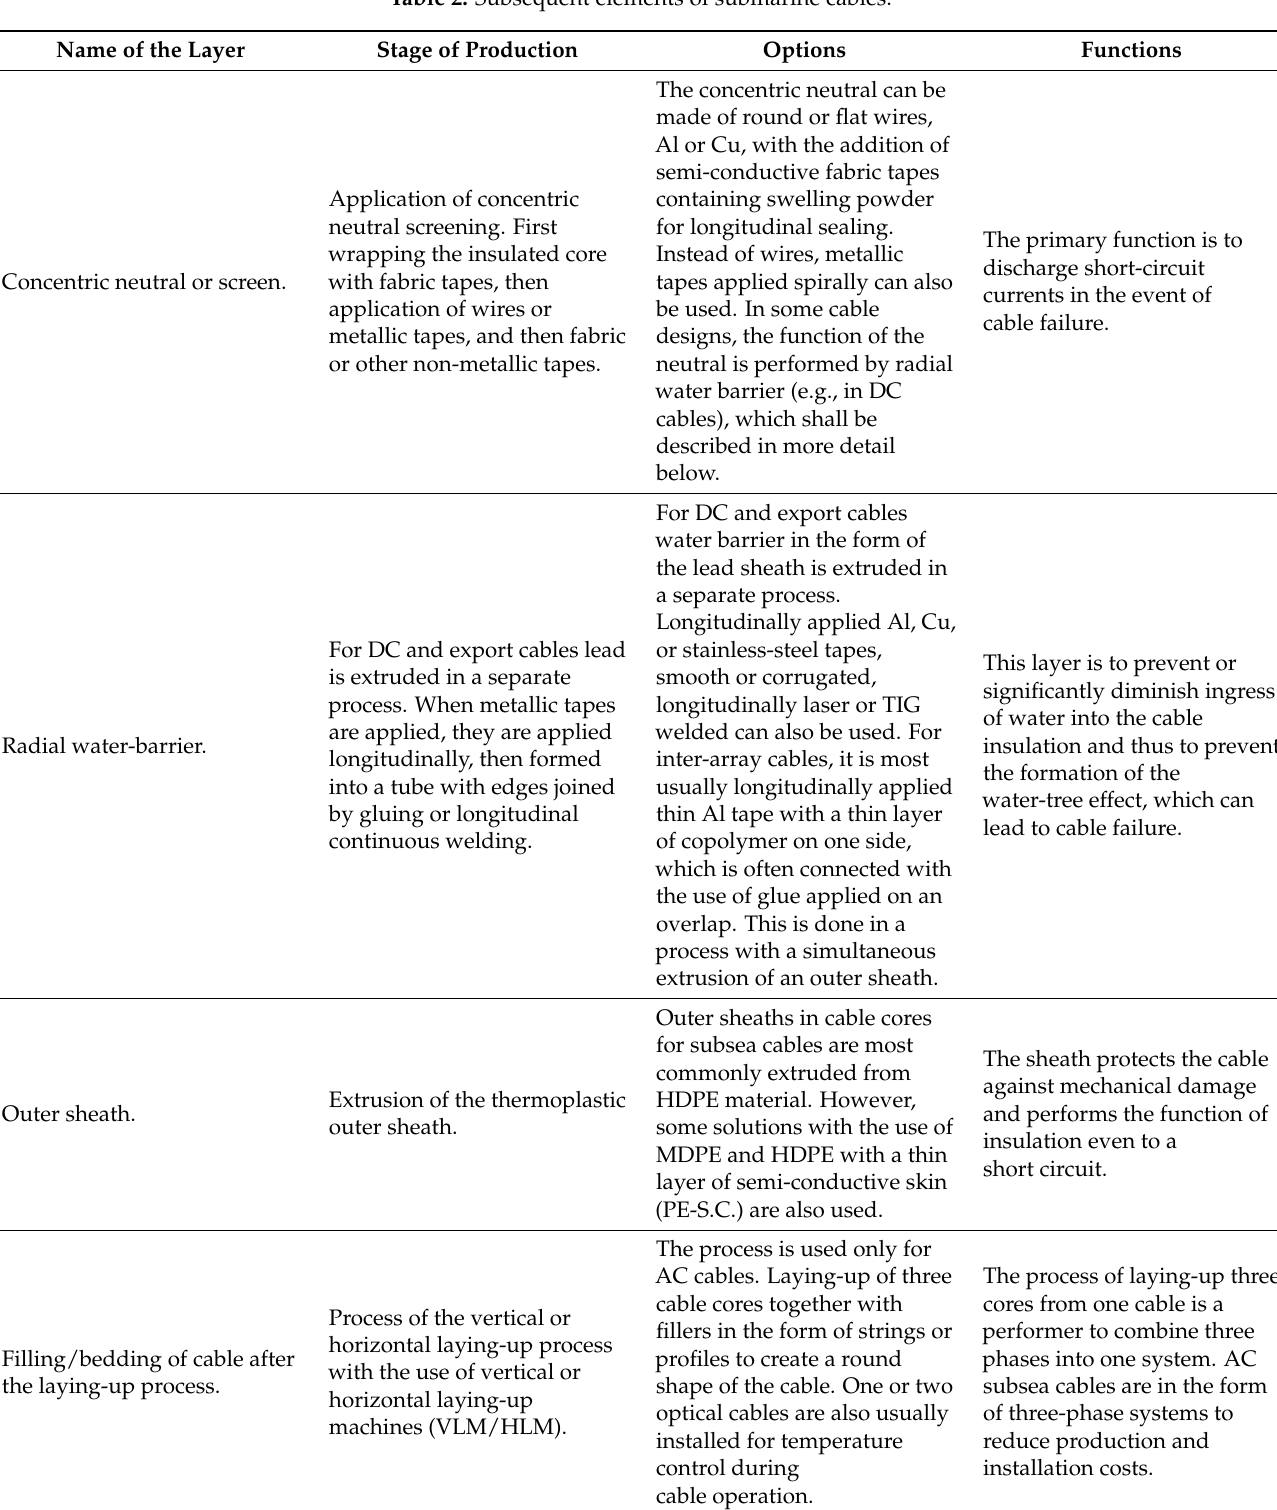
Table 2. Subsequent elements of submarine